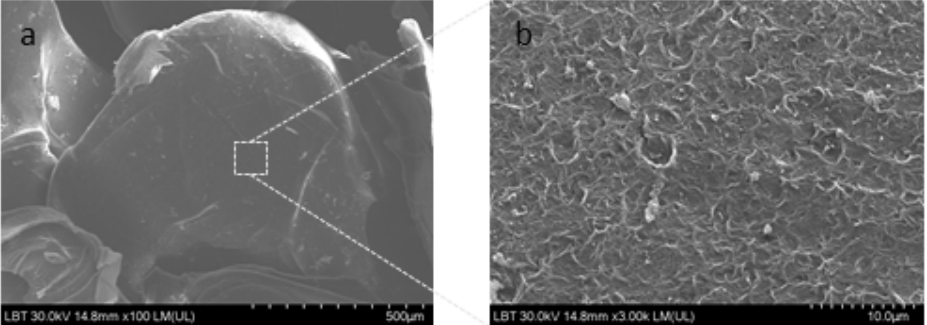
Figure 1. SEM micrographs of the microencapsulated basil extract sample ( a , b ).